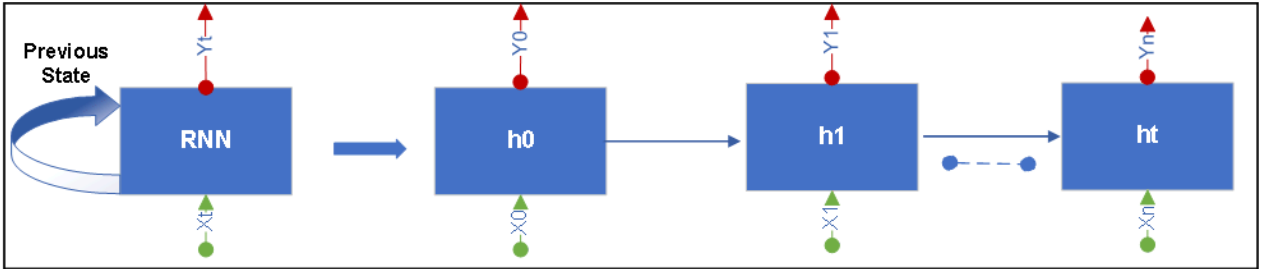
Figure 9. Single-cell of RNN with hidden units.